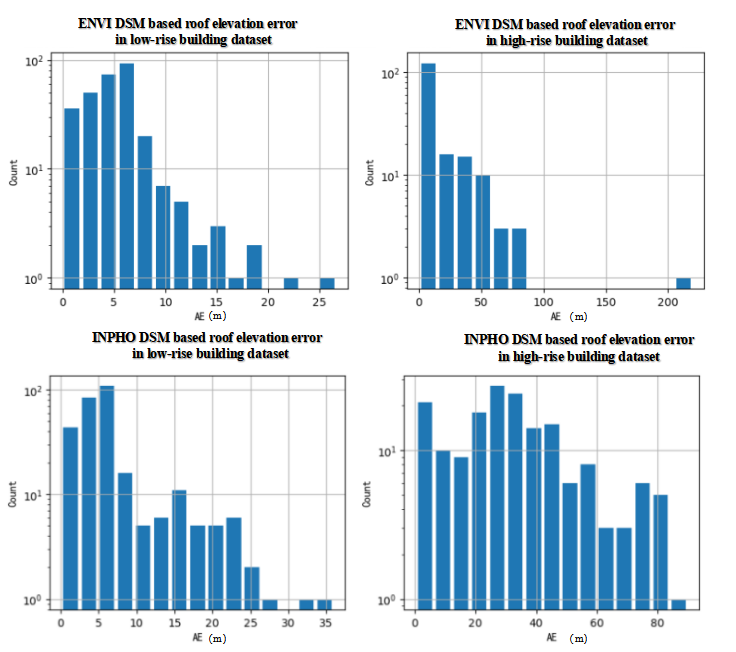
Figure 18. Error distribution of DSM based roof elevation.